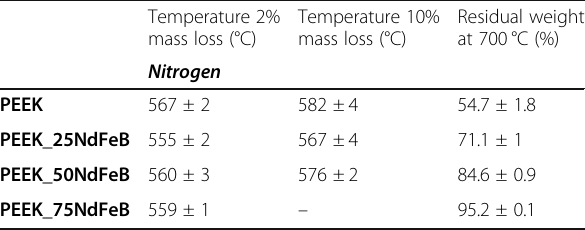
Table 5 Summary of the main results of TGA analysis on filaments in